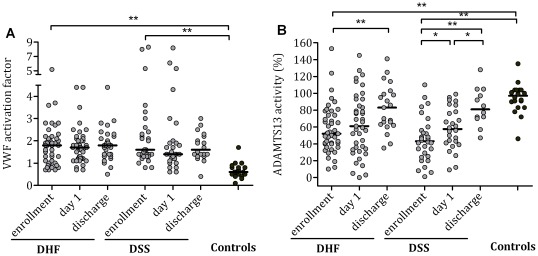
Plasma ADAMTS-13 activity level and VWF activation factor in Indonesian children with dengue.(A) ADAMTS-13 activity level in children with dengue hemorrhagic fever (DHF) and dengue shock syndrome (DSS) and in healthy controls. The ADAMTS-13 activity levels were determined by FRETS-VWF73 assay and are depicted in % of normal pool plasma. (B) VWF activation factors were determined by ELISA using the llama-derived nanobody AU/VWFa-11. The VWF activation factor represents the relative amount of VWF that circulates in an active platelet-binding conformation, whereby the VWF activation factor of normal pooled plasma was referred to as 1. Horizontal lines represent median values. No plasma available for analysis in two patients from the DHF group and one from the DSS group at day 1 and in fifteen and six patients from the DHF and DSS group at discharge. P values were determined by Wilcoxon matched-pairs signed rank test for data in time and Mann Whitney U-test for comparison with the control group. *p value<0.05, **p value<0.01.